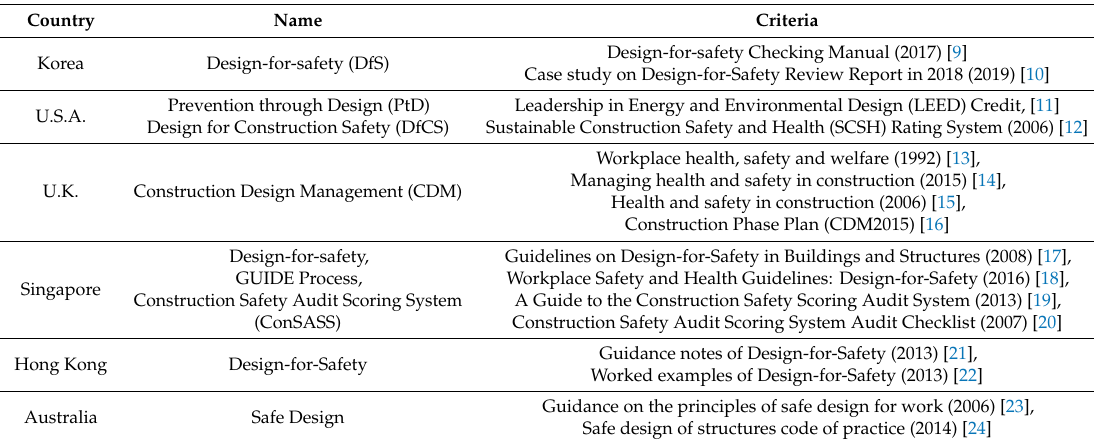
Table 1. Design-for-Safety review